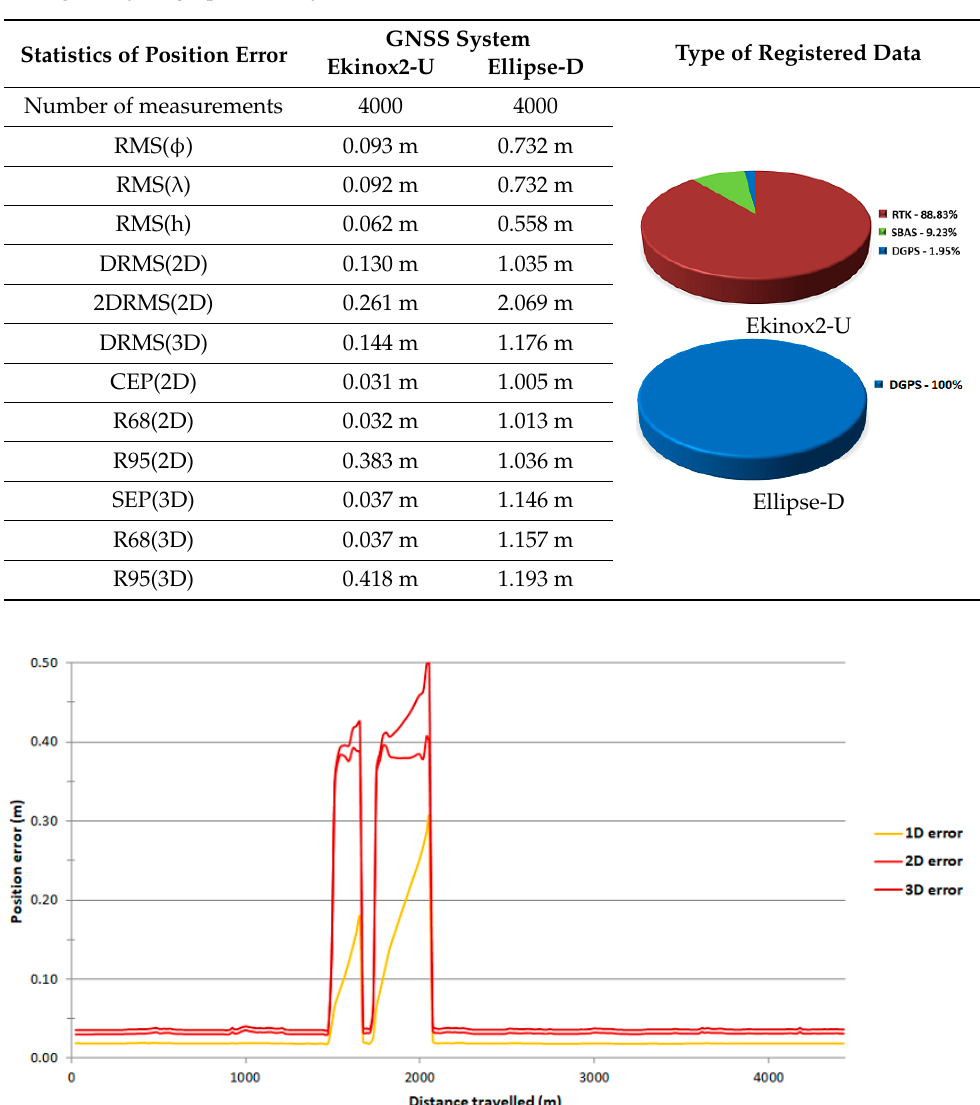
Figure 7. The position error as a function of time (the upper diagram) and three diagrams corre- sponding to the operational status for the following IHO orders: Special (green colour), 1a/1b (blue colour) and 2 (red colour) [81].